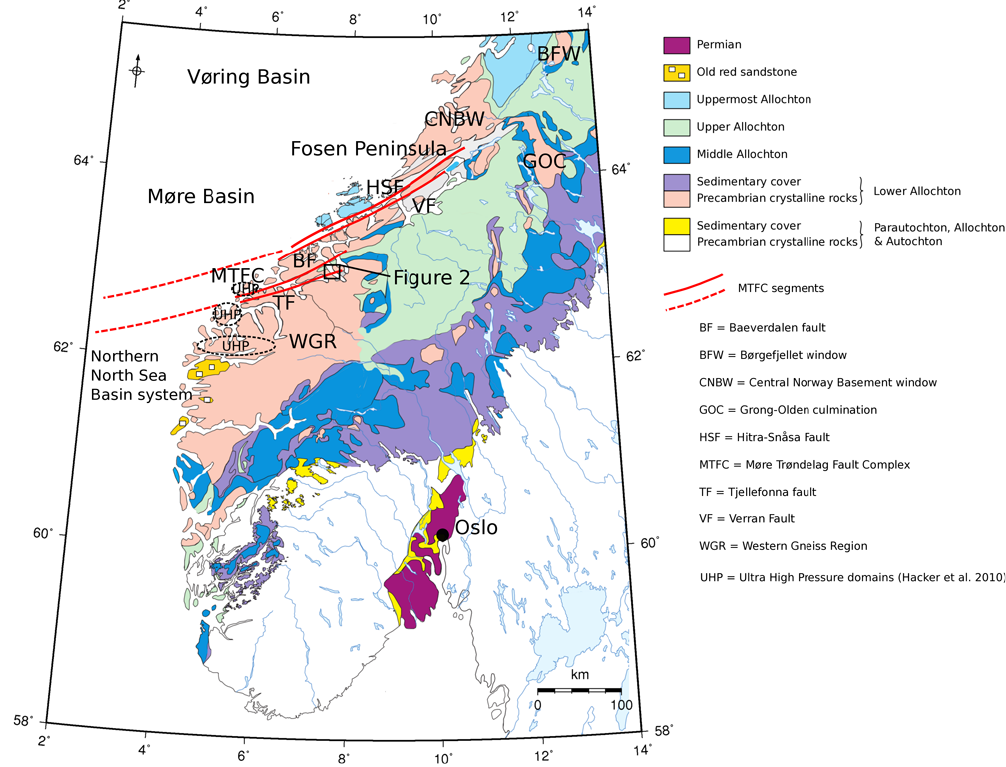
Fig. 1. Tectonostratigraphic map of southern Norway (modified after Mosar et al., 2002) showing the location of the study area in relation to the Western Gneiss Region and the important segments of the Møre-Trøndelag Fault